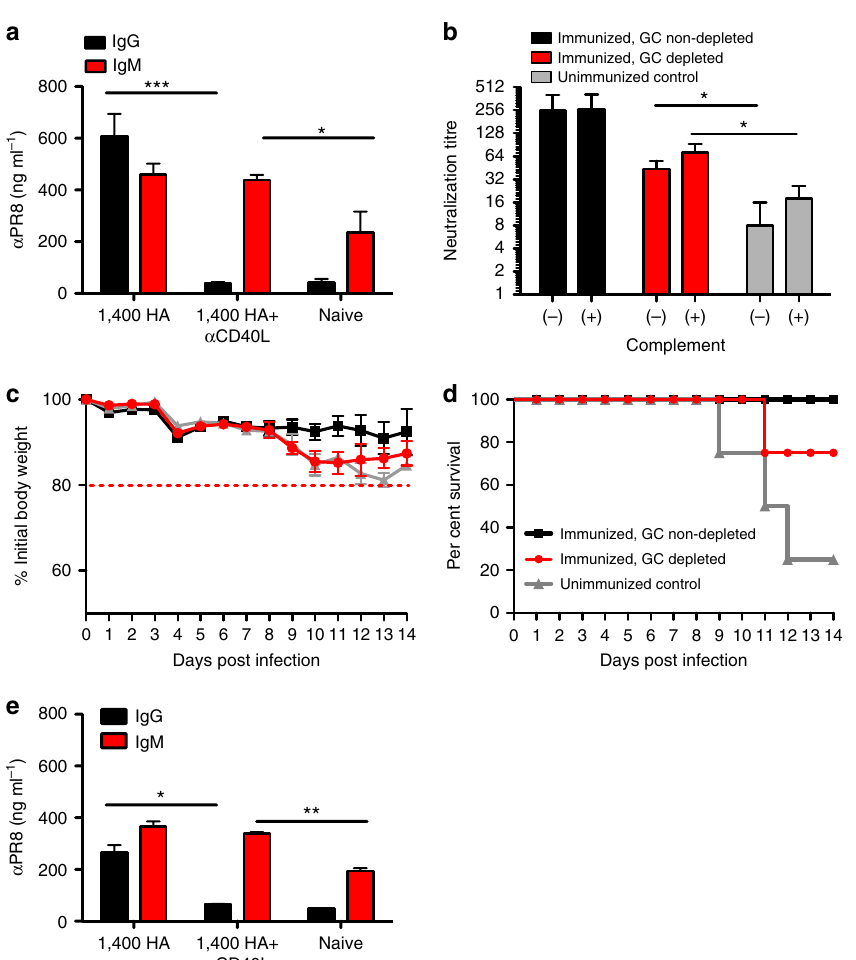
Figure 7 | IgM LLPCs are capable of protecting the animal against infection in vivo in the absence of IgG PCs, memory B cells, and T cell help. ( a ) PR8-specific IgG (filled black square) and IgM (filled red square) titres, respectively, as measured via serum ELISA from cohorts at 1 month post infection with 0.1xLD 50 PR8 virus—treated with control Ig or a CD40L at days 6, 8 and 10 to inhibit GCs—or age-matched naive control mice (filled grey square open square n ¼ 4). ( b ) Neutralization of PR8 virus by 1 months sera from PR8-immunized cohorts, with (filled red square) or without (filled black square) a CD40L treatment, or age-matched naive controls (filled grey square open square n ¼ 4), with or without complement. Mice immunized with A/ PR/8/34 virus, with or without a CD40L treatment, were then treated with anti-CD4/CD8 at 1 and 3 days before infection and challenged with 2xLD 50